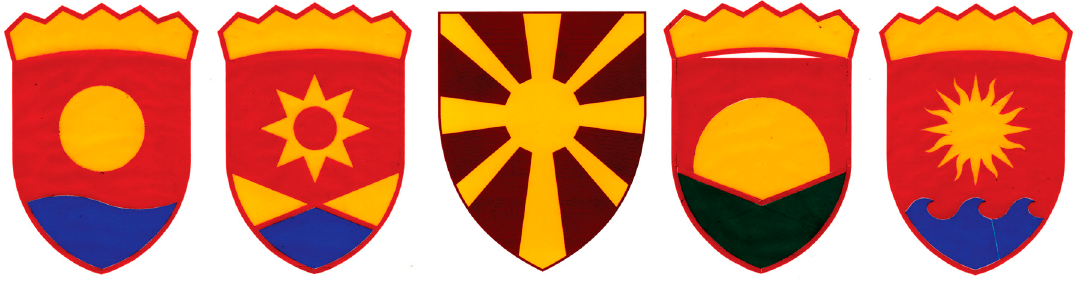
Figure 7. Proposals by Miroslav Grchev.